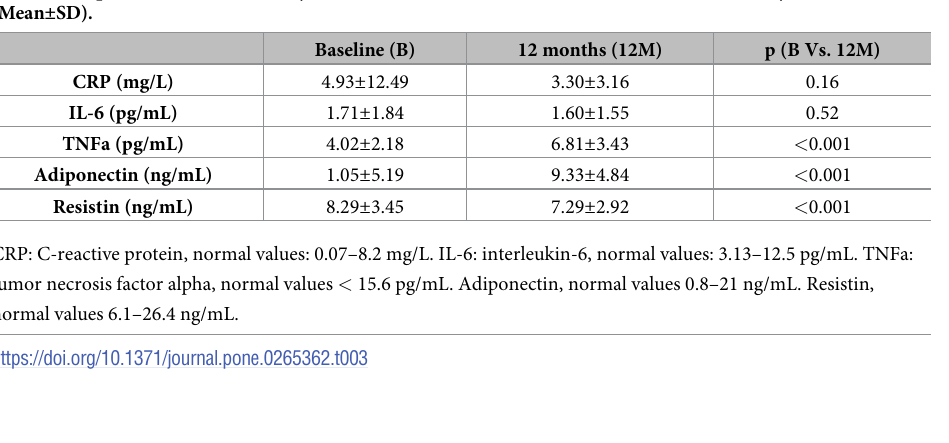
Table 3. Adipokine and inflammatory biomarker levels at baseline and after 12 months of lifestyle modification (Mean ± SD). Baseline (B)